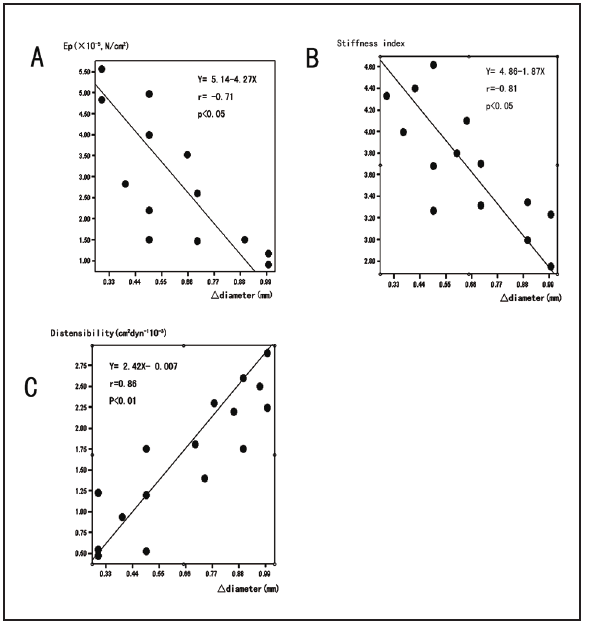
Figure 2. Correlations between the Ep (A), Stiffness index (B), distensibility (C) and the diameter.